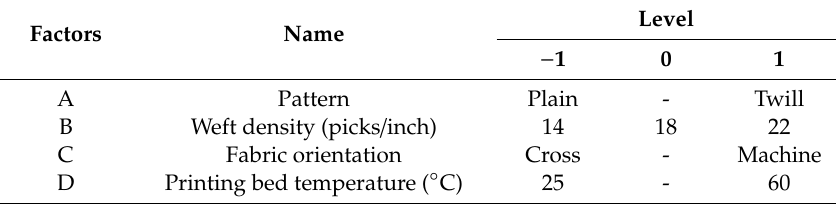
Table 2. Factors of the statistical design of experiments and their levels for abrasion measurements.